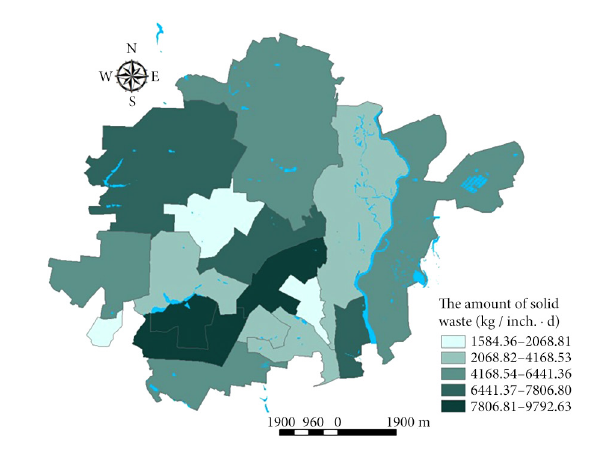
Figure 6. Geoinformation modeling of the urban environment by indicatirs of amount of solid household wastes (kg/inh.